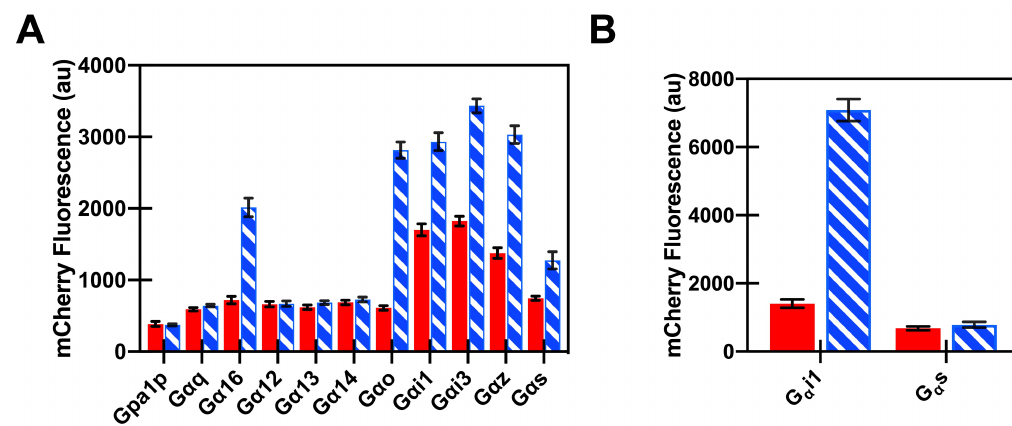
Figure 5. Downstream signaling in engineered yeast cells enables determination of G α coupling preferences. Agonist (100 µ M NECA, blue hatched bars) mediated downstream signaling responses as compared to control (DMSO, red filled bars) for A 1 R were measured in yeast expressing Gpa1p-human G α chimeras ( mean ± S.D., for three independent experiments) for either modified GSK strains ( A ) or Broach laboratory strains ( B